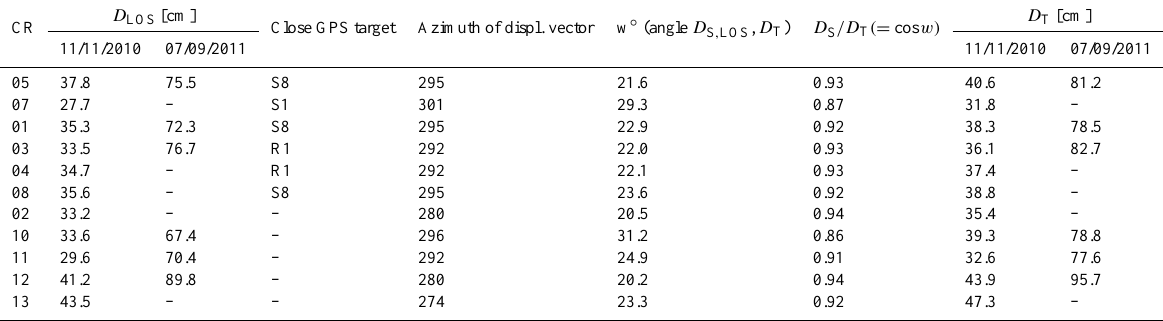
Table 4. Total displacements in CRs ( D T ) from February until November 2012 calculated from GB-SAR LOS displacements ( D LOS ) using the angle between LOS and the total displacement